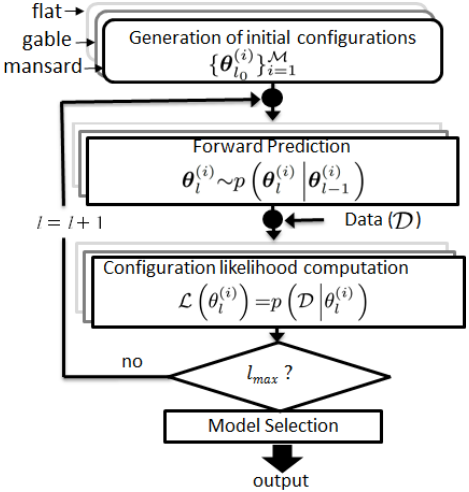
Figure 2: Roof fitting using sequential importance